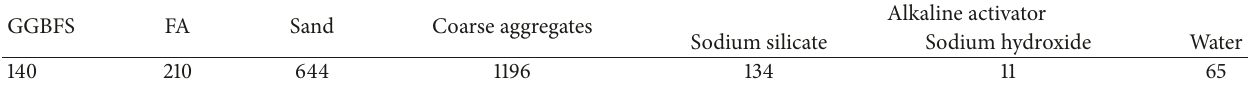
Figure 1: Test sample details. Table 2: Geopolymer concrete mixture composition (kg/m 3 ).